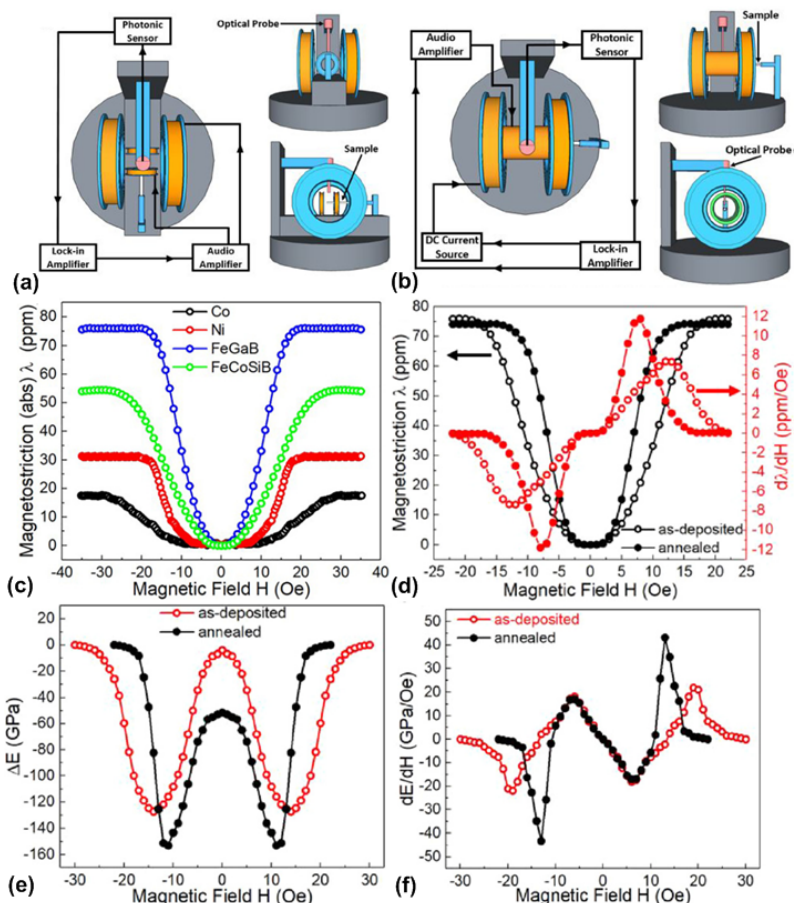
Figure 1. ( a ) Schematic of the proposed magnetostriction tester in three-view; ( b ) schematic of the proposed delta-E tester in three-view; ( c ) measured magnetostriction with respect to magnetic field for different magnetic thin films; ( d ) measured magnetostriction and piezomagnetic coefficient for as-deposited and annealed FeGaB thin films; ( e ) measured delta-E effect for as-deposited and annealed FeGaB thin films; and ( f ) measured dE / dH for as-deposited and annealed FeGaB thin films. This figure is reproduced with permission from American Institute of Physics (AIP) Publishing, [63].